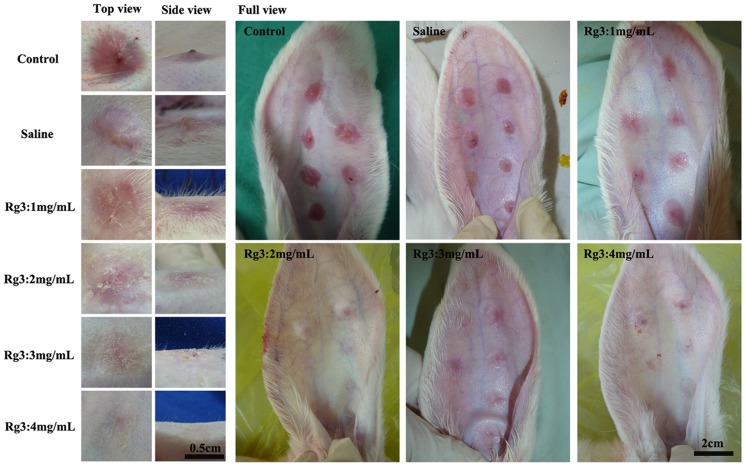
The clinical appearance of the wounds and scars.The top views, side views and full views of the scars that were left untreated and those that had been treated with different concentrations of Rg3 (0, 1, 2, 3 and 4 mg/mL). The wounds that had received injections of Rg3 (1, 2, 3 and 4 mg/mL) are obviously flattened and less reddish than the control and the placebo groups.